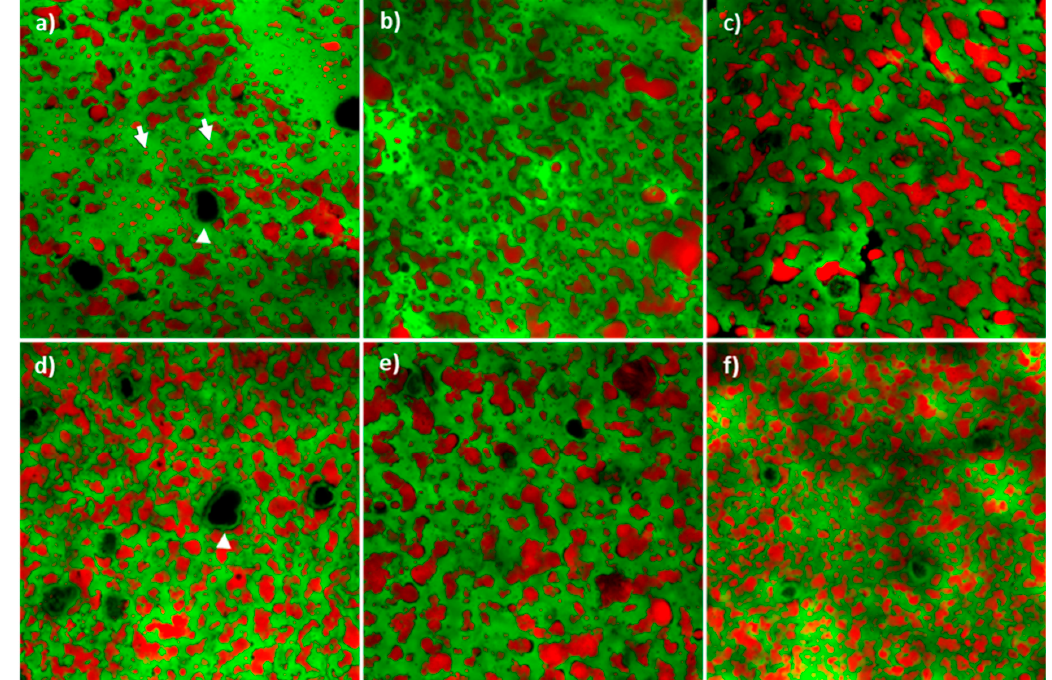
Figure 3. Confocal microscopy images of 12 months ( a ), 18 months ( b ), 24 months ( c ), 30 months ( d ), 40 months ( e ) and 50 months ( f ) ripened Parmigiano Reggiano cheeses. Intact fat globules (white arrows, panel a) were mostly observed in 12-month ripened Parmigiano Reggiano cheese. Calcium phosphate crystals (white arrowheads, panels a and d ) were present at all ripening times.